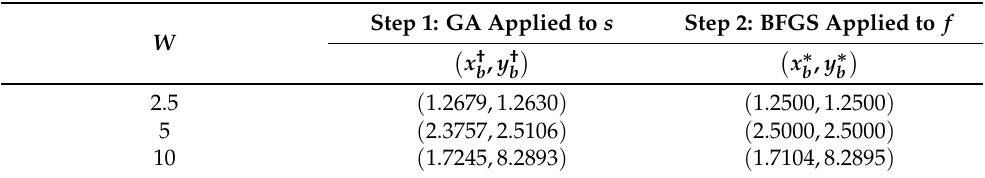
Table 3. The maximizers found by the hybrid method for the case of a single helix and three sizes of the flow meter (7): W = 2.5, 5, and 10. W